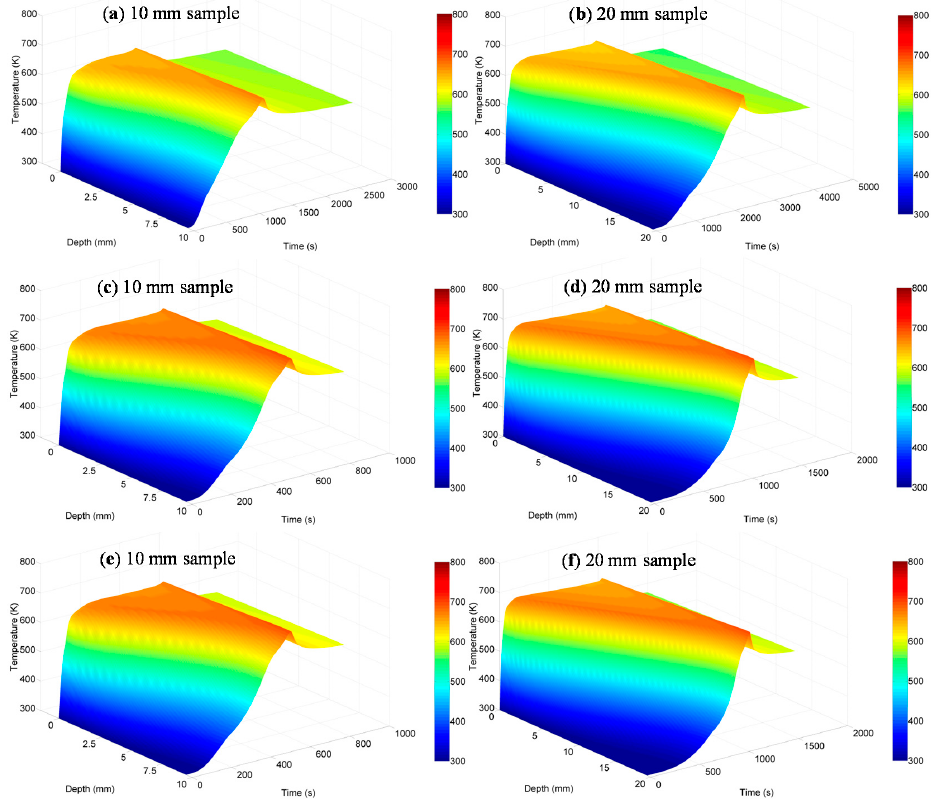
Figure 3. The temperature profiles inside the PMMA slabs under different heat fluxes: ( a , b ) 25 kW/m 2 ; ( c , d ) 50 kW/m 2 ; and ( e , f ) 75 kW/m 2 .